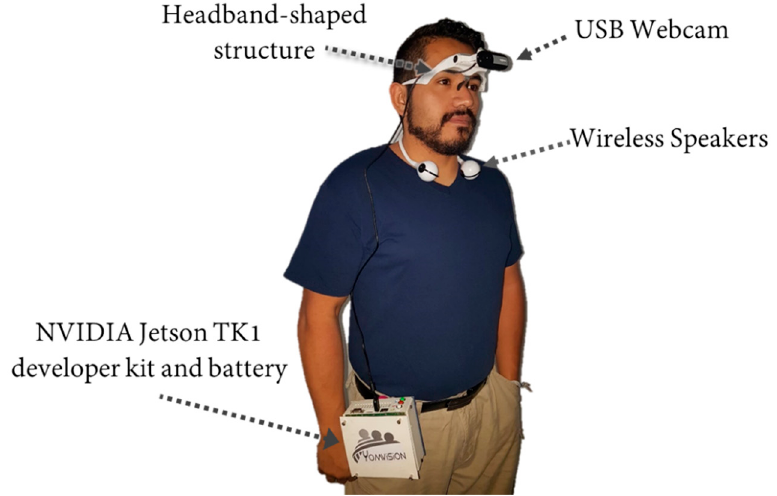
Figure 18. Integration of the face recognition system in real time which says aloud the name of the